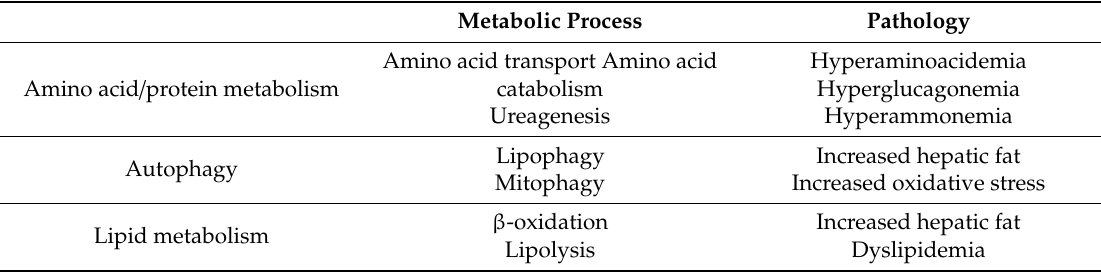
Table 1. The molecular mechanisms that may be impaired by hepatic glucagon resistance inhibition and the pathologies that are